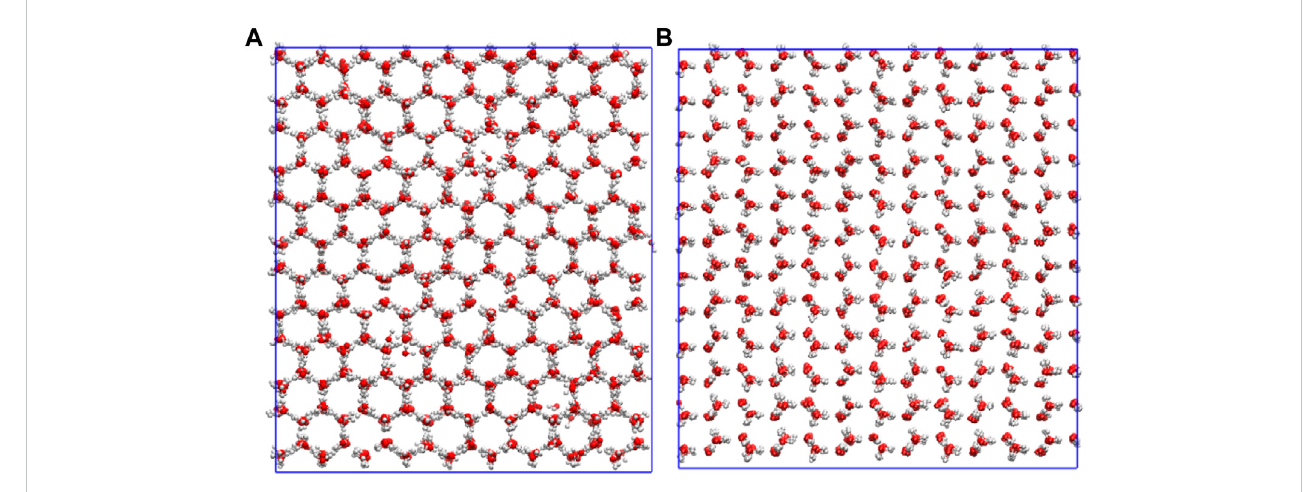
FIGURE 1 Ice model used for MD simulation [ (A) : ice Ih-type; (B) : ice